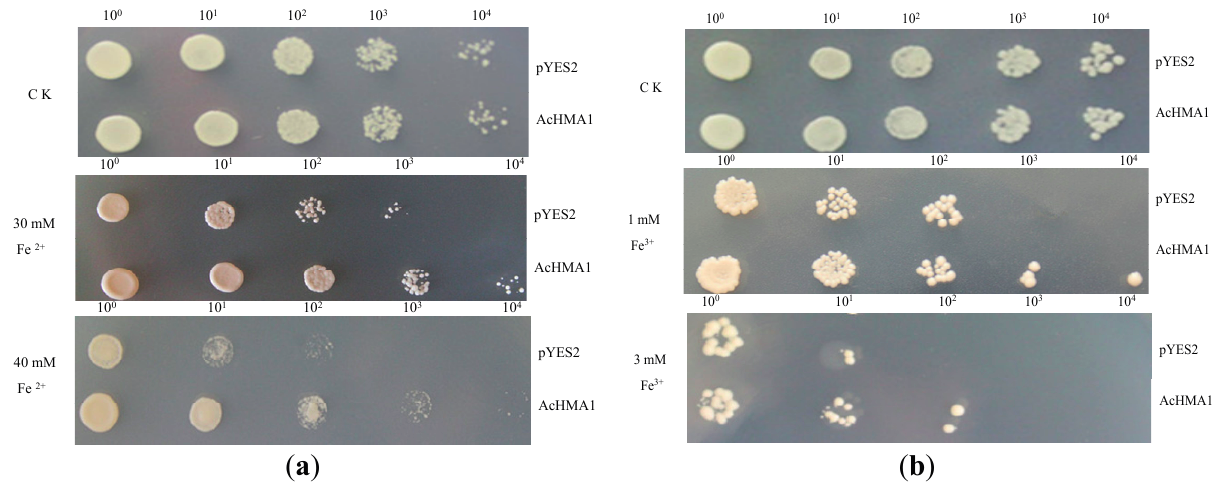
Figure 3. Fe tolerance of AcHMA1 -transformed yeast. ( a , b ) Yeast cells transformed with vector pYES2 or with AcHMA1 -pYES2 were grown in Synthetic complete medium were adjusted with SC-U to 1, 0.1, 0.01, dropout uranium (SC-U) for 24 h, and their OD 600 0.001, 0.0001, two microliters of diluted cultures were spotted onto medium supplementing excess Fe 2+ or Fe 3+ ; ( c , d ) Growth of yeast cells expressing AcHMA1 and the control cell in the medium containing different concentrations of Fe 2+ or Fe 3+ . The yeast transformants were grown in medium containing 2% galactose for 24 h at 28 °C, then adjusted = 2 in 1 mL of medium for experiments. The cells were in 5 mL cultures containing OD 600 different concentrations of Fe at 28 °C for 24 h with shaking. Cell densities were measured ) after each treatment. The yeast cell incubated in medium containing 2% galactose (OD 600 was measured after 24 h as the control. The data are expressed as the mean ± SE of three replicates; * and ** indicate significant levels at 5% and 1%, respectively. Yeast cells transformed with vector pYES2 were used as